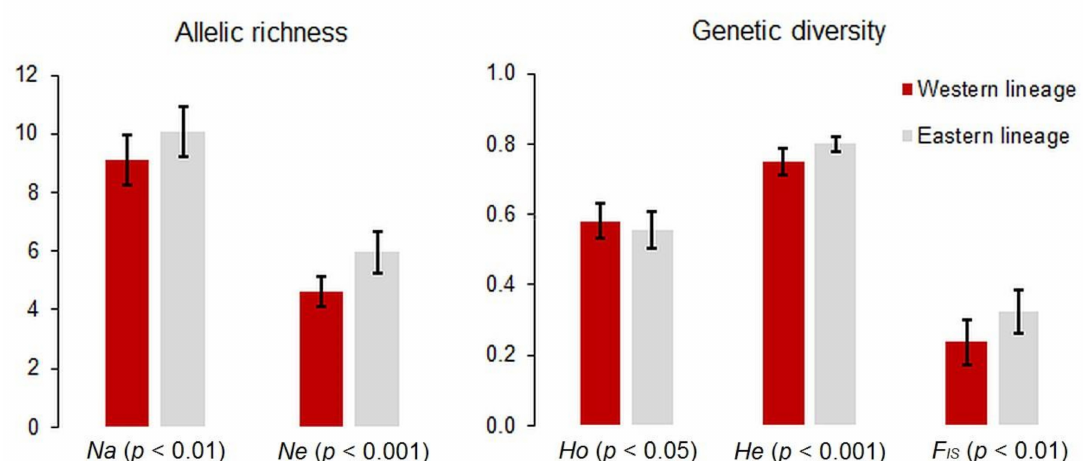
Figure2. Parametersofallelicrichnessandgeneticdiversityintheeasternandwesternmaternallineages: N a —number of di ff erent alleles per locus, N e —number of e ff ective alleles per locus, H o —observed heterozygosity, H e —unbiased expected heterozygosity, F IS —inbreeding coe ffi cient. The significance levels ( p ) of a two-sided permutation test for di ff erences between the lineages are given in brackets.